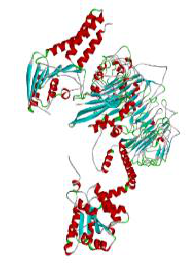
Figure 8. 3D model of vaccine-TLR3 and TLR9 complexes.